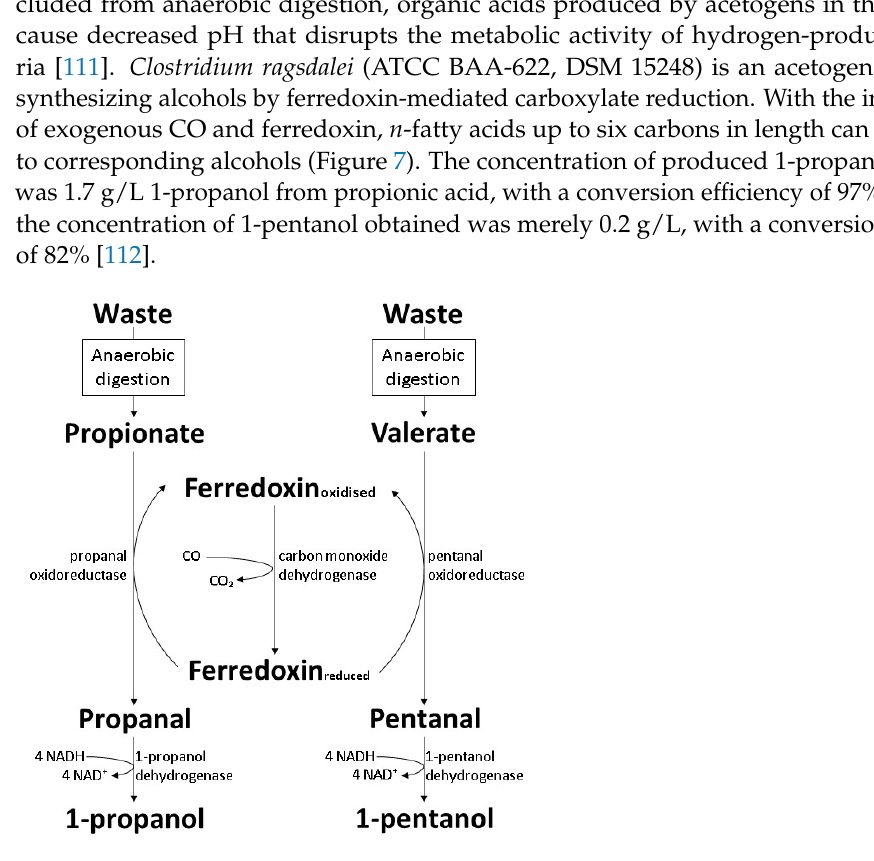
Figure 7. Biosynthesis of 1-propanol and 1-pentanol by wild-type C. ragsdalei through the carboxylate reduction pathway